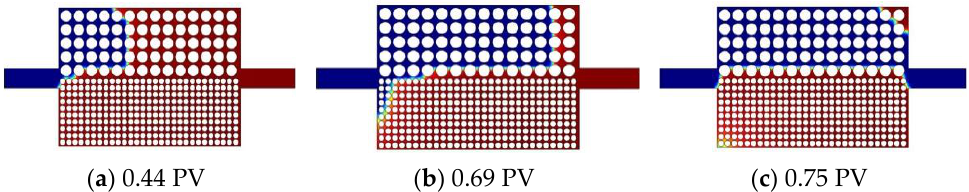
Figure 4. Oil saturation distribution of partial perforation and commingling production-injection. (The polymer solution is represented in blue and the oil in red).